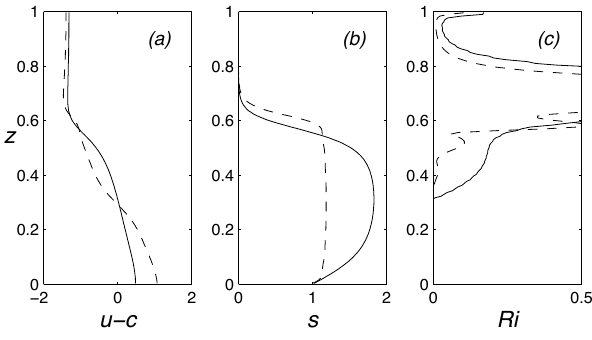
Fig. 5. The vertical profiles of (a) u − c , (b) s , and (c) Ri through the center of the solitary waves at t = 0 (solid) and t = 200 (dashed) in Fig. 3.